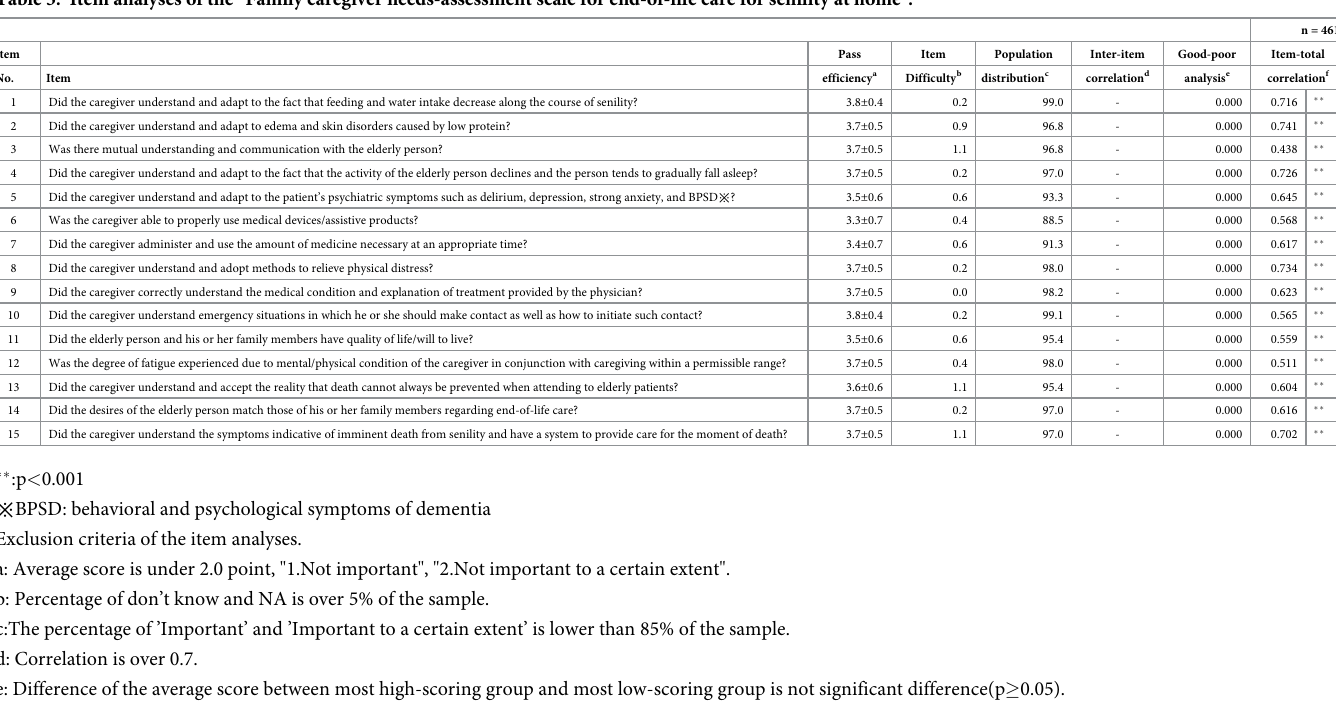
Table 3. Item analyses of the "Family caregiver needs-assessment scale for end-of-life care for senility at